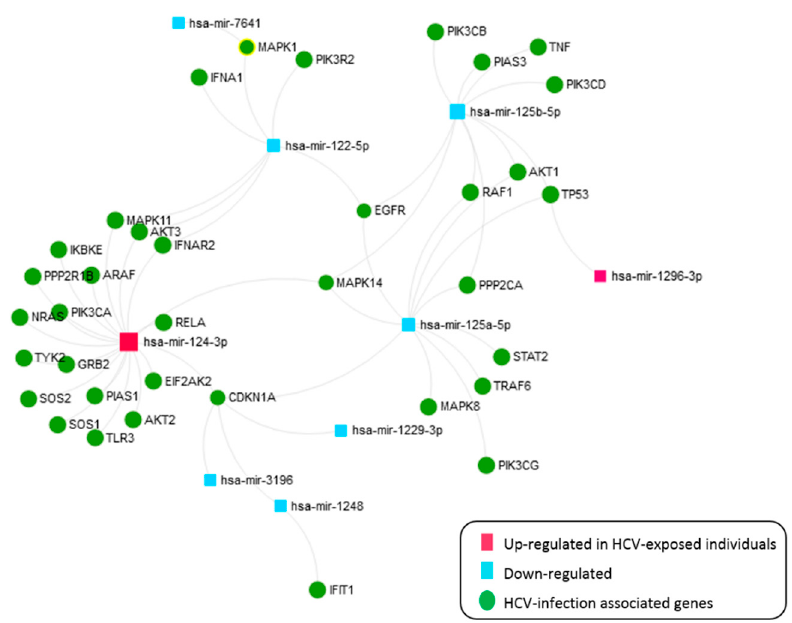
Figure 7. An interactive network of SDE miRNAs in CHC patients and SC individuals versus HC, corresponding to the HCV KEGG pathway.